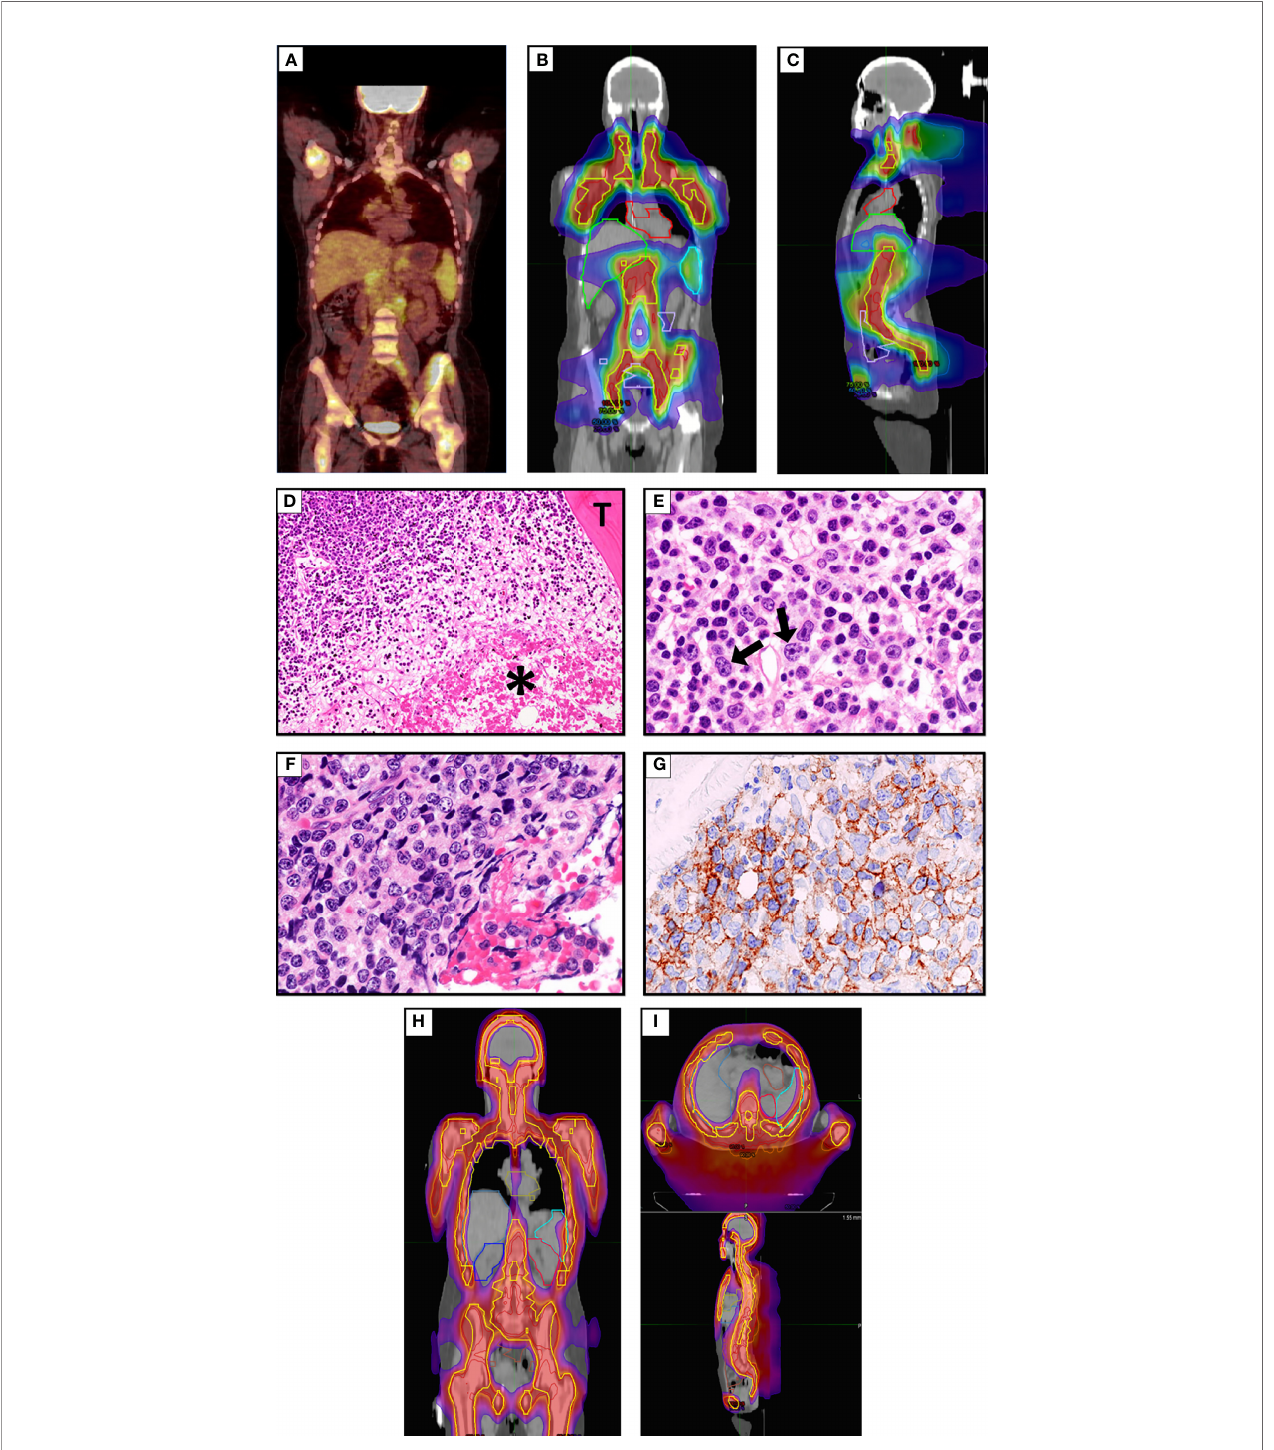
FIGURE 1 | (A) FDG-PET/CT coronal maximum intensity projection (MIP) image before sTLI showing avid uptake of BM, multiple lymph nodes and iliopsoas muscle. (B, C) sTLI dose distribution color wash (B) , coronal view (C) , sagittal view. (D) Massive BM involvement by DLBCL. The asterisk * indicates a large area of necrosis. T indicates a BM trabecula (Hematoxylin – Eosin; × 100). (E) An area from the same section as (D) showing in fi ltration by low grade B-cell lymphoma and occasional large cells (arrows) (Hematoxylin – Eosin; ×400). (F) The same section as (D) showing another area in fi ltrated by DLBCL cells (Hematoxylin – Eosin; ×400), that express the CD19 molecule (G) (Leica immunoperoxidase staining; ×400). (H, I) Total marrow irradiation (TMI) dose distribution color wash (H) , coronal view (I) , axial and sagittal